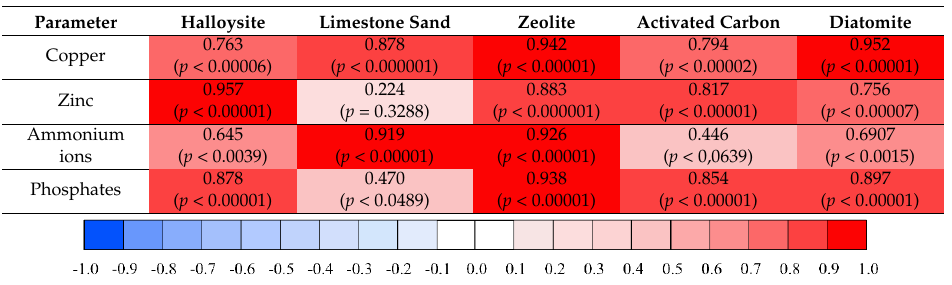
Figure 3. Impact of temperature on the efficiency of Cu and Zn removal with equations describing the relationship at initial concentrations of 30 mg Cu/L and 7.5 mg Zn/L (error bars mark the standard deviation, dashed line is the theoretical curve. Table 3. Values of Pearson’s coefficients ( R ) for the relationship between the equilibrium sorption capacity ( Q e ) of the reactive materials and temperature ( n = 21; initial concentrations: 10 mg NH 4 -N/L;